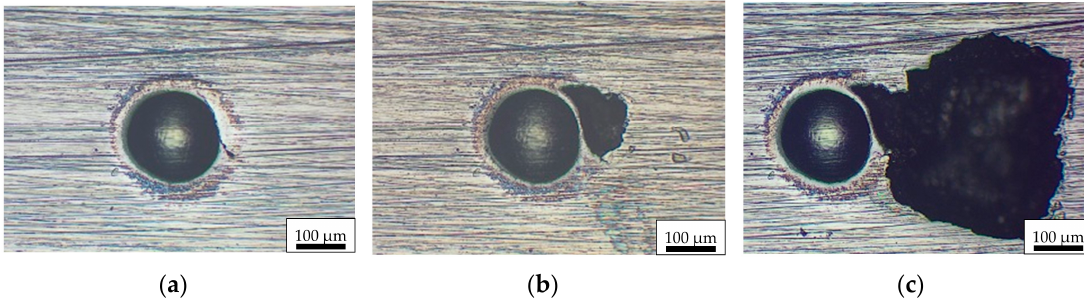
Figure 10. Evolution of spalling on a dent generated on a ring with a nano-scale, bainitic structure formed at 220 °C for 24 h: ( a ) 36 h, ( b ) 48 h, and ( c ) 60 h.